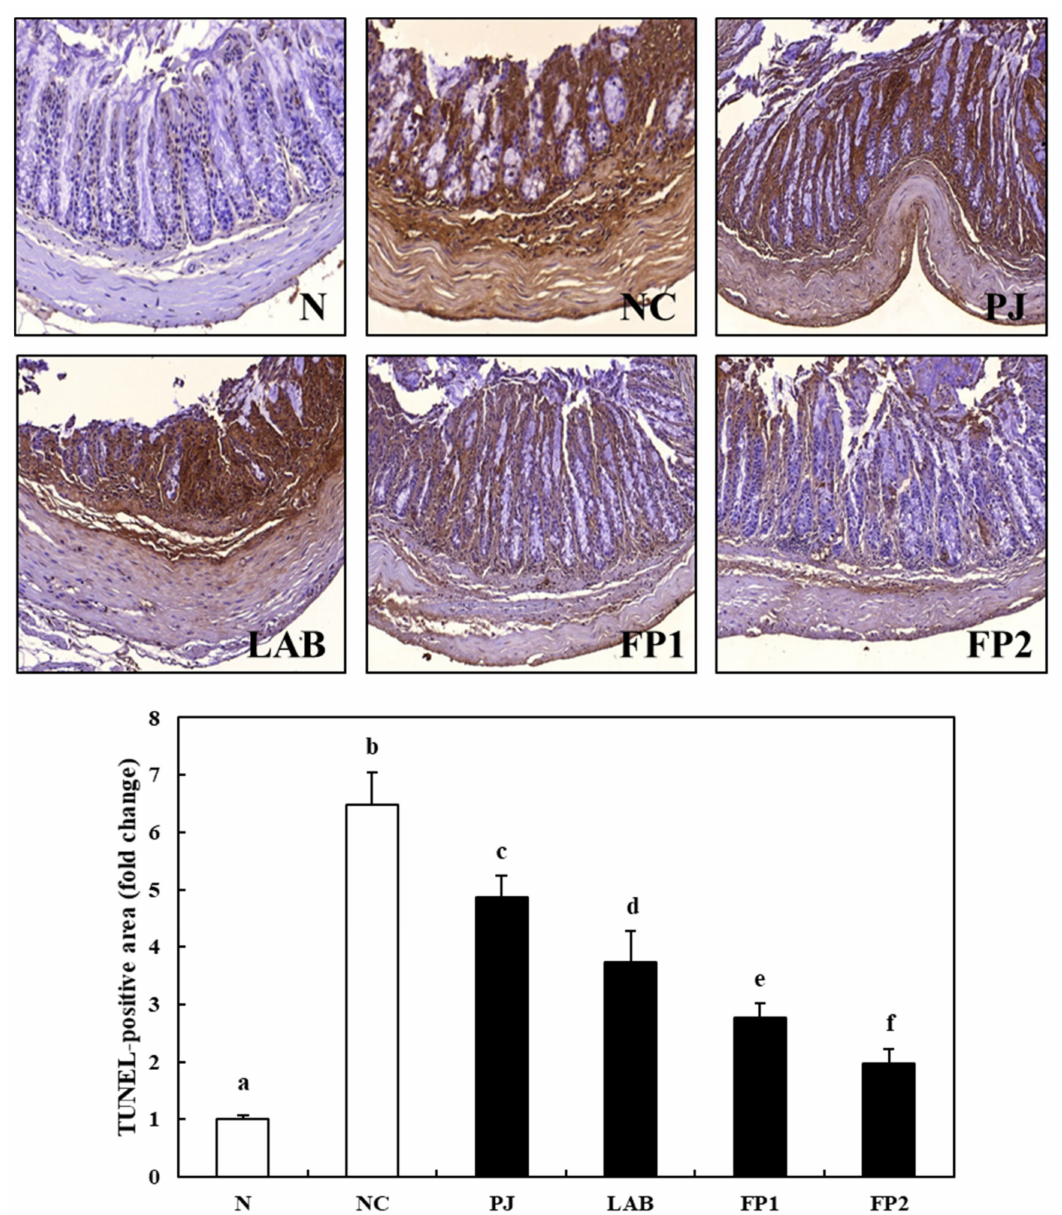
Figure 8. Effects of FP on TUNEL stained cell apoptosis in colonic tissue to DSS-induced colitis mice. Magnification: × 200. N, normal group, non-DSS treatment; NC, negative control group, DSS treatment and supplementation with distilled water; PJ; Prunus mume juice (PJ) group, DSS treatment and supplementation with 200 mg/kg of 2.5% PJ; LAB, lactic acid bacteria (LAB) group, DSS treatment and supplementation with 200 mg/kg of L. plantarum and L. casei suspended by distilled water; FP1, low dose of fermented Prunus mume juice (FP) group, DSS treatment and supplementation with 100 mg/kg of FP; FP2, high dose of FP group, DSS treatment and supplementation with 200 mg/kg of FP. Data values are expressed as the means ± S.D. ( n = 6). The data are analyzed with one-way ANOVA and different letters on the bar show the difference in Duncan’s multiple range test ( p <